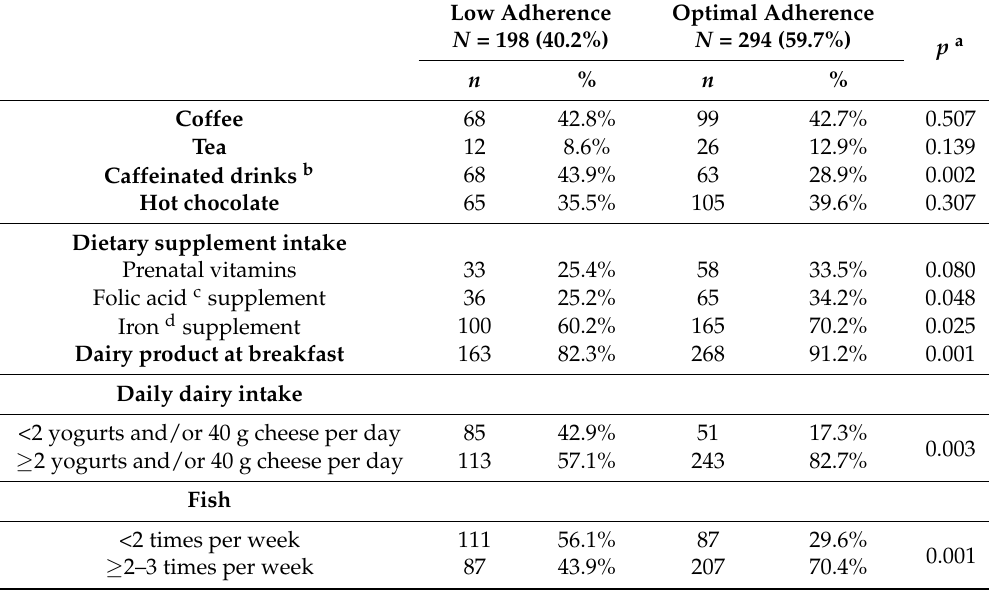
Table 2. Maternal dietary habits. Low Adherence N = 198 (40.2%)